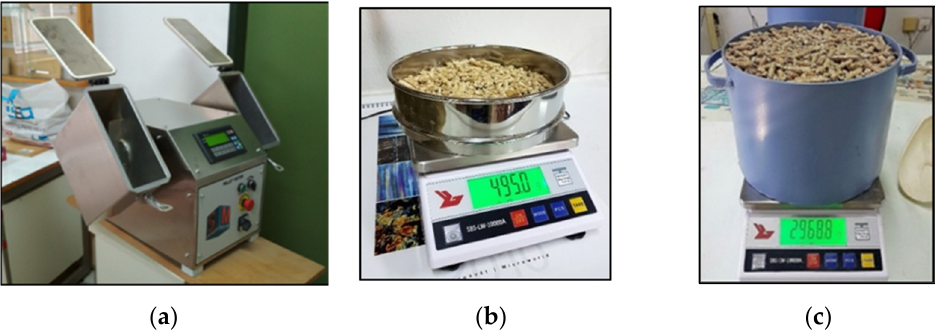
Figure 1. ( a ) Mechanical durability testing device, ( b ) pellet material in a sieve with 3.15 mm holes, ( c ) bulk density measurement container (167 mm diameter, 228 mm height, volume of 5 L).